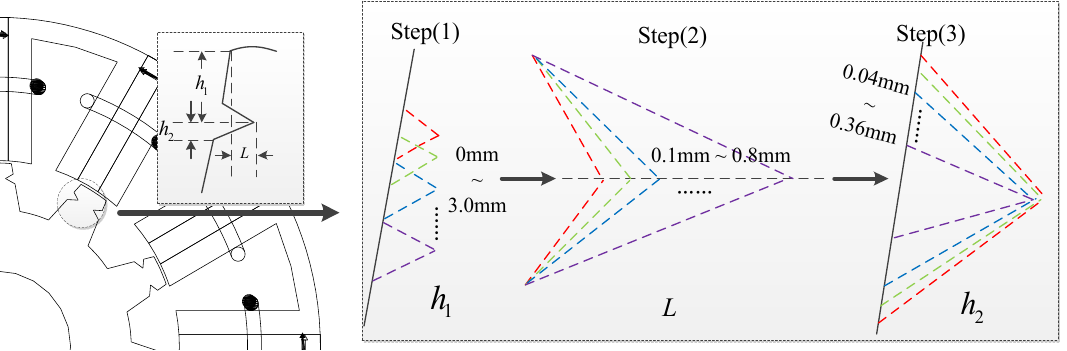
Figure 5. The design procedure of rotor with notched teeth model.